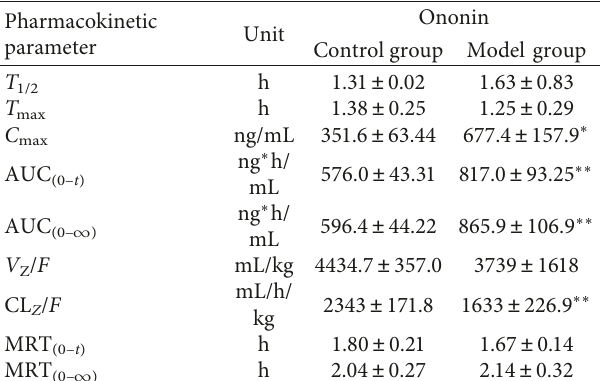
Table 10: The pharmacokinetic parameters of ononin after HQD administration ( x ± SD, n � 8).